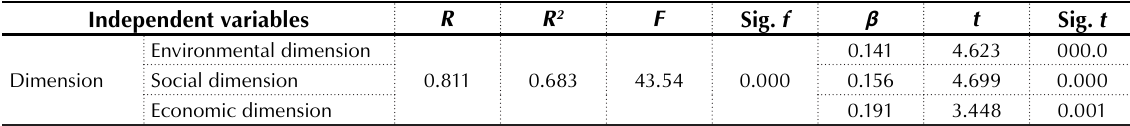
Table 4. Results of the main hypothesis testing